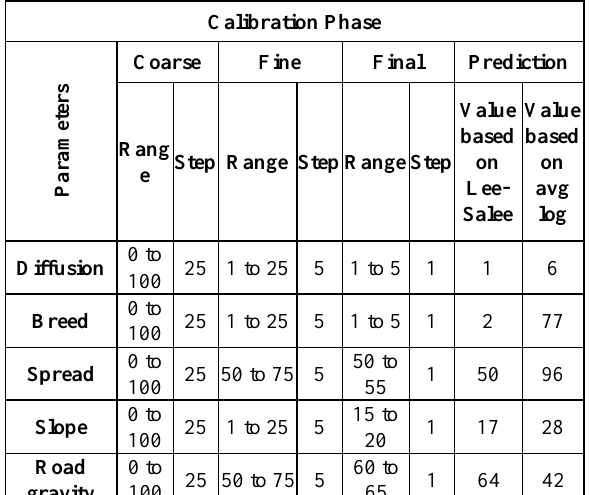
Figure 9: Simulated urban growth for the year 2026 –